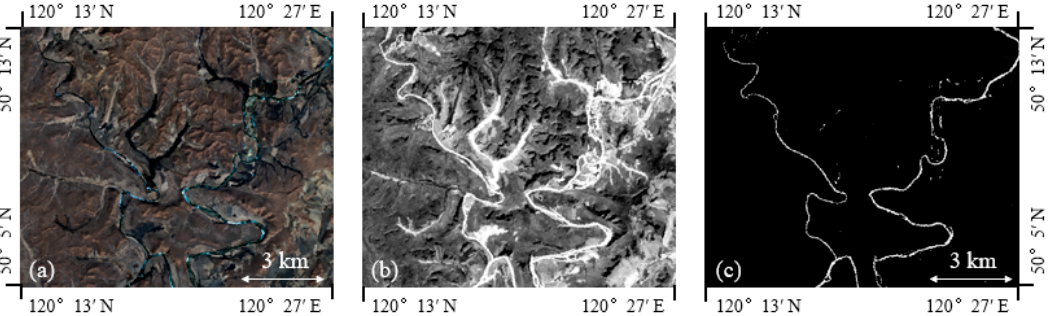
Figure 4. Image processing of Landsat 8 data: (a) an original image, (b) normalized difference water index (NDWI) results, and (c) the extracted waterbody distribution.